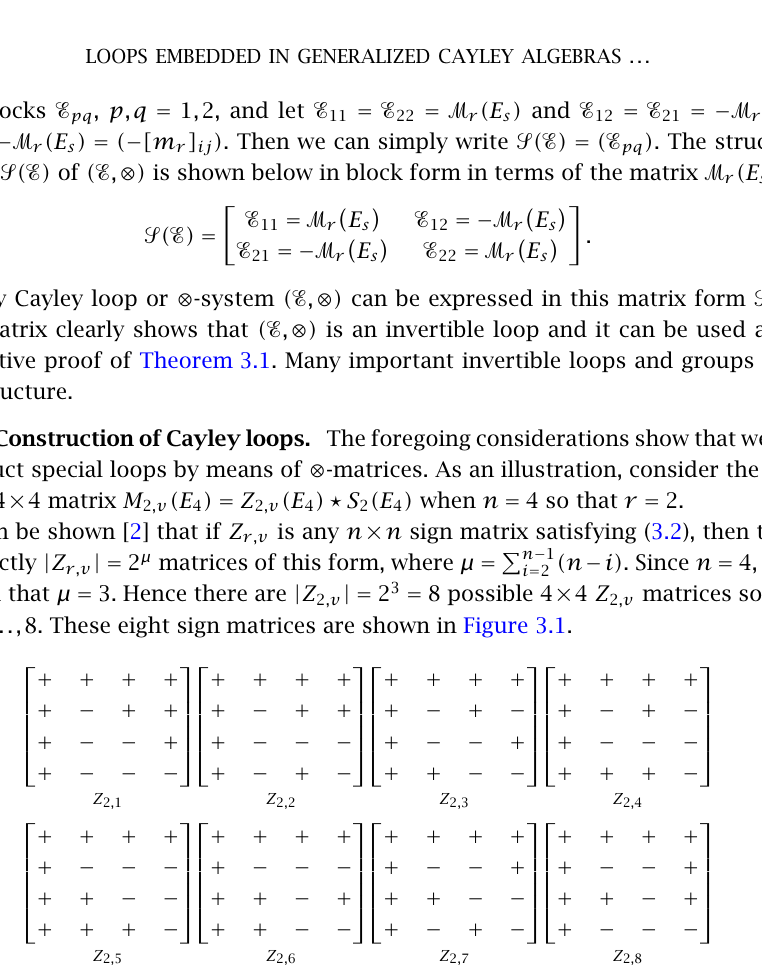
Figure 3.1 . Eight possible Z -matrices Z 2 ,v that can be used to form